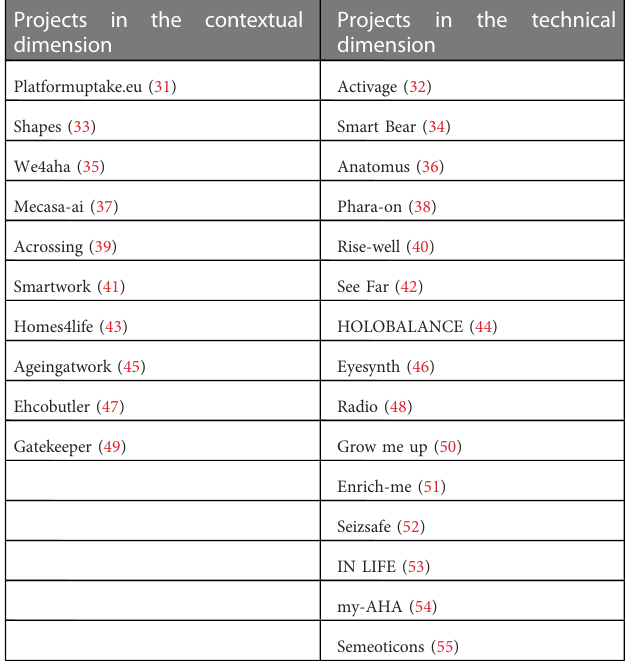
TABLE 1 Projects classi fi cation in the contextual and technical